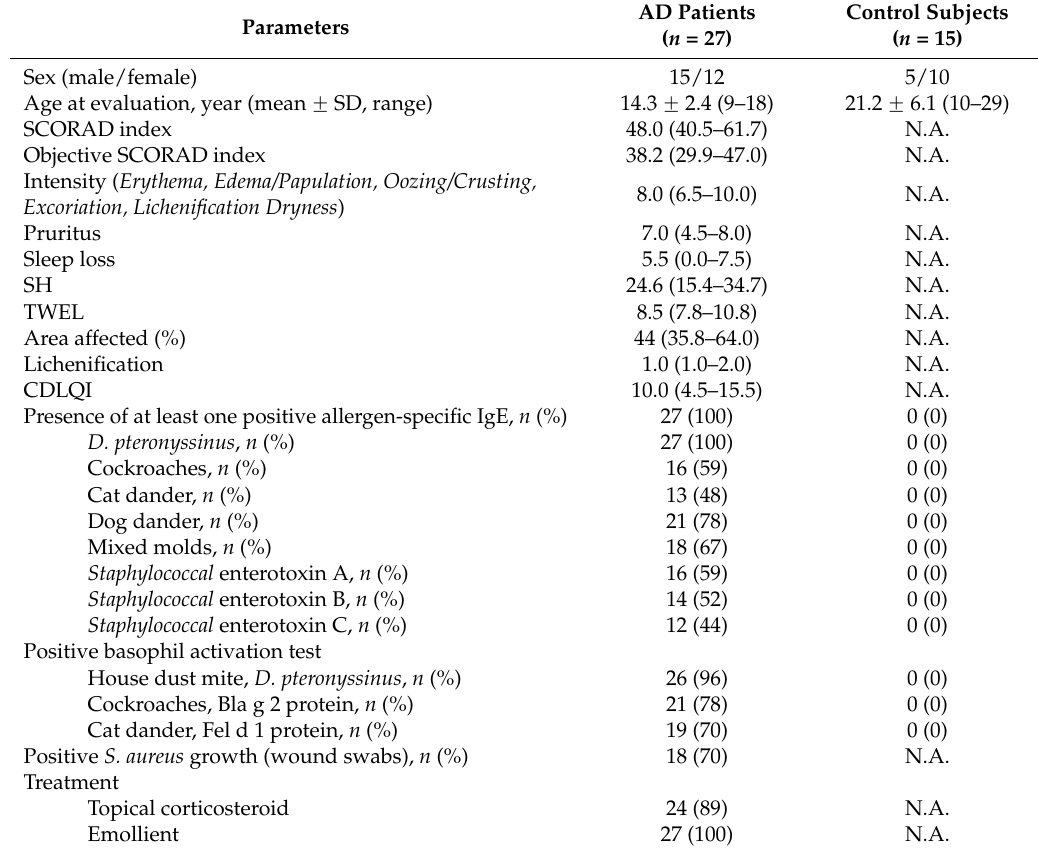
Table 1. Demographic, clinical and laboratory data of the atopic dermatitis (AD) patients.